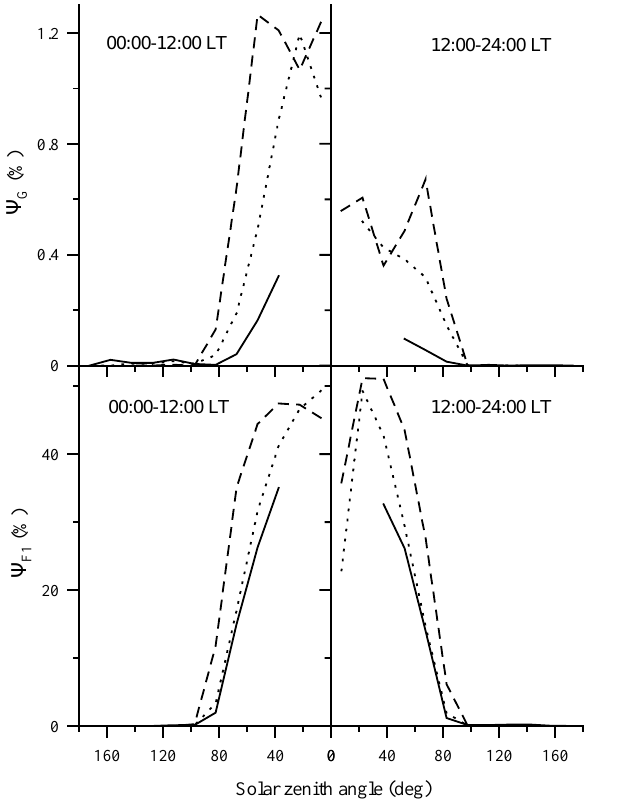
Fig. 3. The dependence of the F1-layer (bottom panels), and G con- dition (top panels) probability functions on the solar zenith angle in latitude range 3 (30 ◦ < | ϕ | ≤ 45 ◦ , 30 ◦ < | 8 | ≤ 45 ◦ ) during the winter (solid lines), summer (dashed lines), and spring and autumn (dotted lines) months before midday from 00:00LT to 12:00LT (left panels), and after midday from 12:00LT to 24:00LT (right panels).